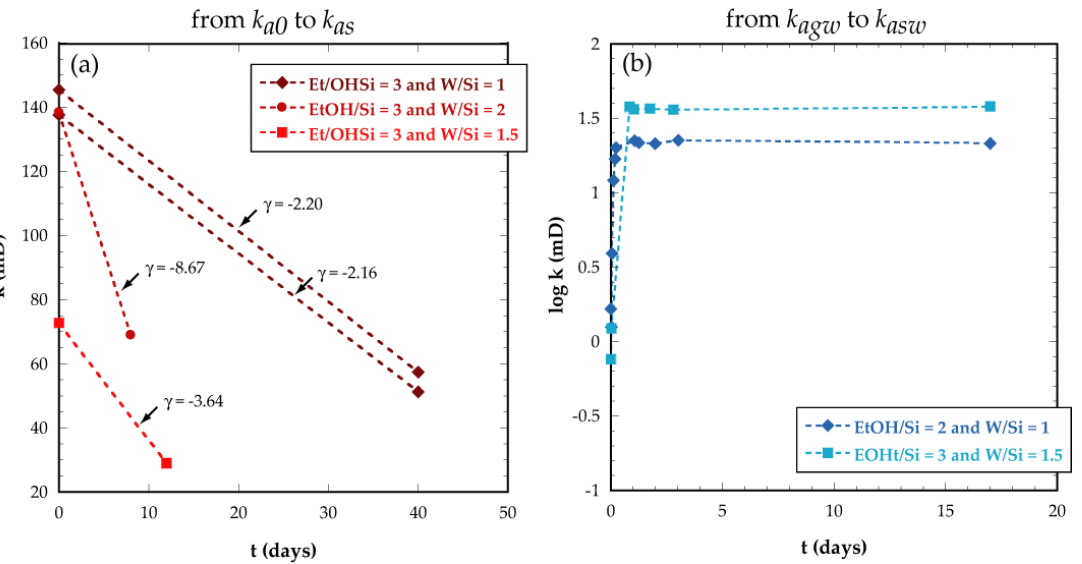
Figure 7. ( a ) Air permeability decrease as a function of the W/Si ratio; ( b ) Variation in air permeability during hydrogel drying for two hydrogel-filled cores immersed in water during 20 days. The values of the slope (γ) are indicated in Figure 7a.